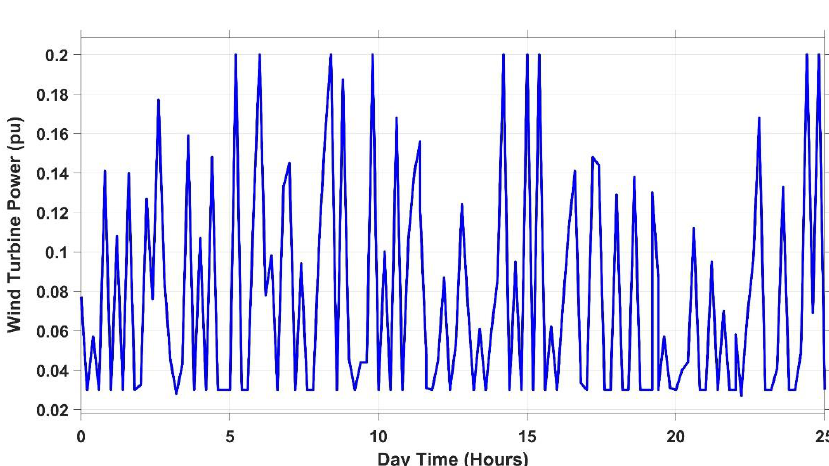
Figure 15. Wind speed fluctuation.